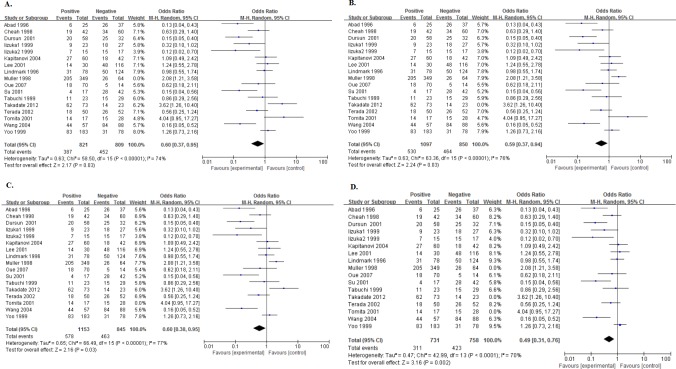
Forest plot of odds ratio (OR) for sensitivity analysis of the association between NME1 overexpression and overall survival (OS) in patients with random effects model.A. The ORs for OS without “Muller 1998”; B. The ORs for OS without “Takadate 2012”; C. The ORs for OS without “Tomita 2001”; D. The ORs for OS without these three studies.